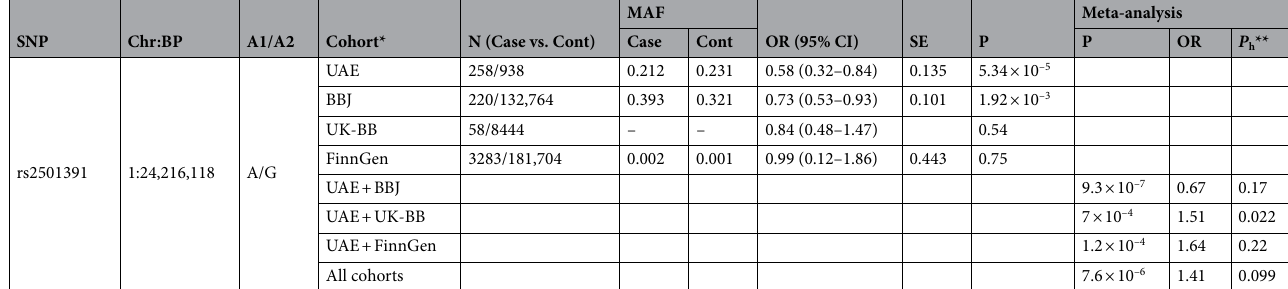
Table 2. GWAS and replication results of the SNP rs2501391 in CRN2 gene with DKD in the UAE cohort and replication cohorts from Biobank Japan, UK Biobank, and FinnGen project. A1: effective allele; BP: base pair, indicating chromosomal location; Chr: chromosome; CI: confidence intervals; Cont: controls; MAF: minor allele frequency; OR: odds ratio, SE: standard error. *Cohorts: UAE: United Arab Emirates cohort, BBJ: